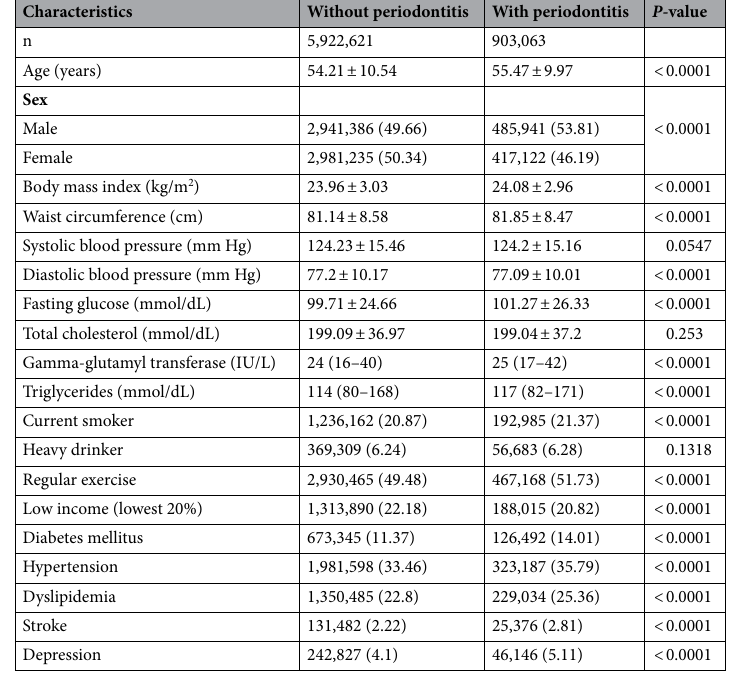
Table 1. Baseline characteristics of the study population according to the presence of Parkinson’s disease. The data were presented as the mean ± standard deviation for continuous variables or the number (percentage) for categorical